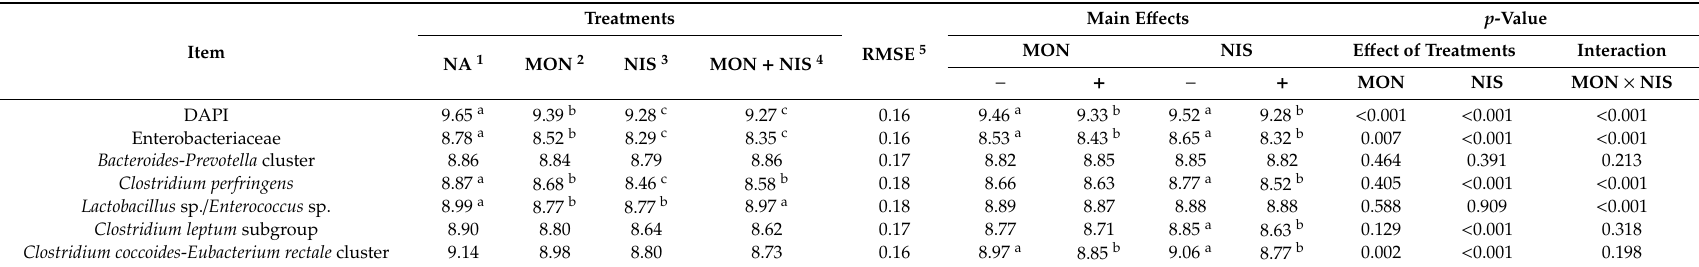
Lactobacillus sp. / Enterococcus